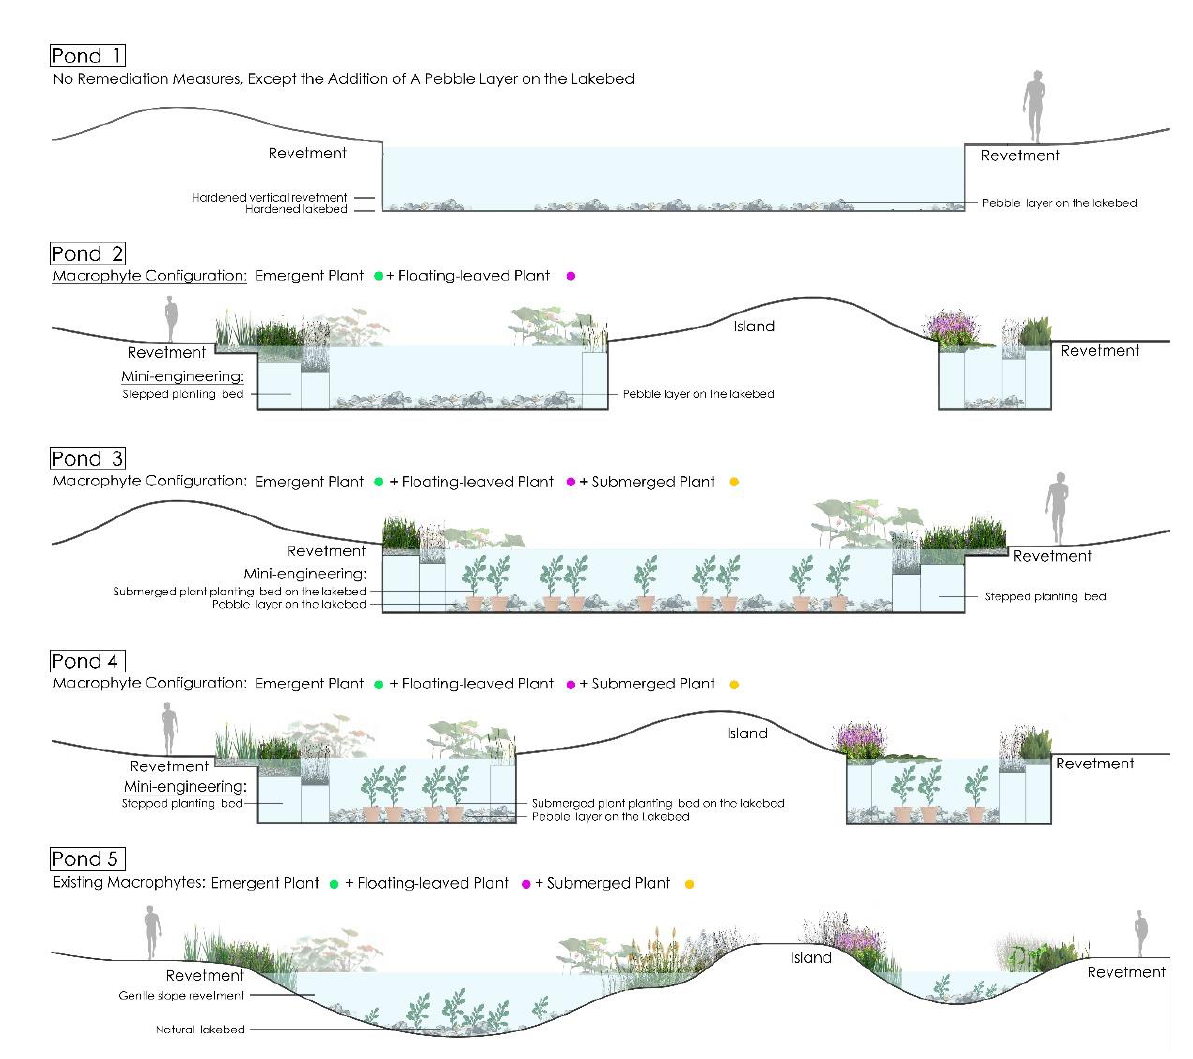
Figure 2. Landscape profile of each pond after ecological remediation design. Table 3. Types and species of aquatic macrophytes in each